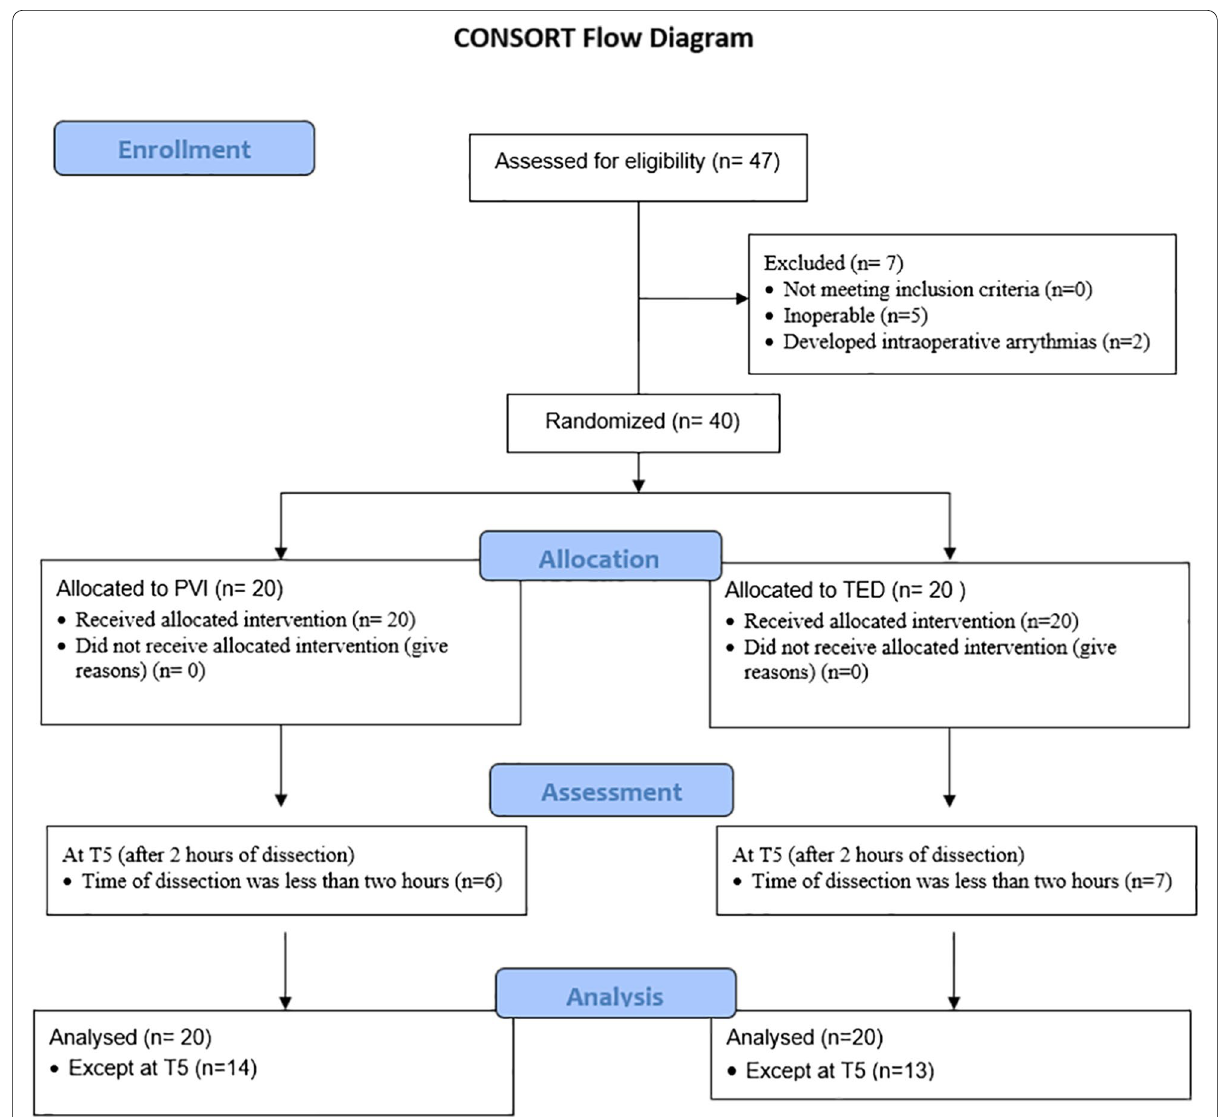
Fig. 1 CONSORT flow diagram showing patients’ allocation at different stages of the